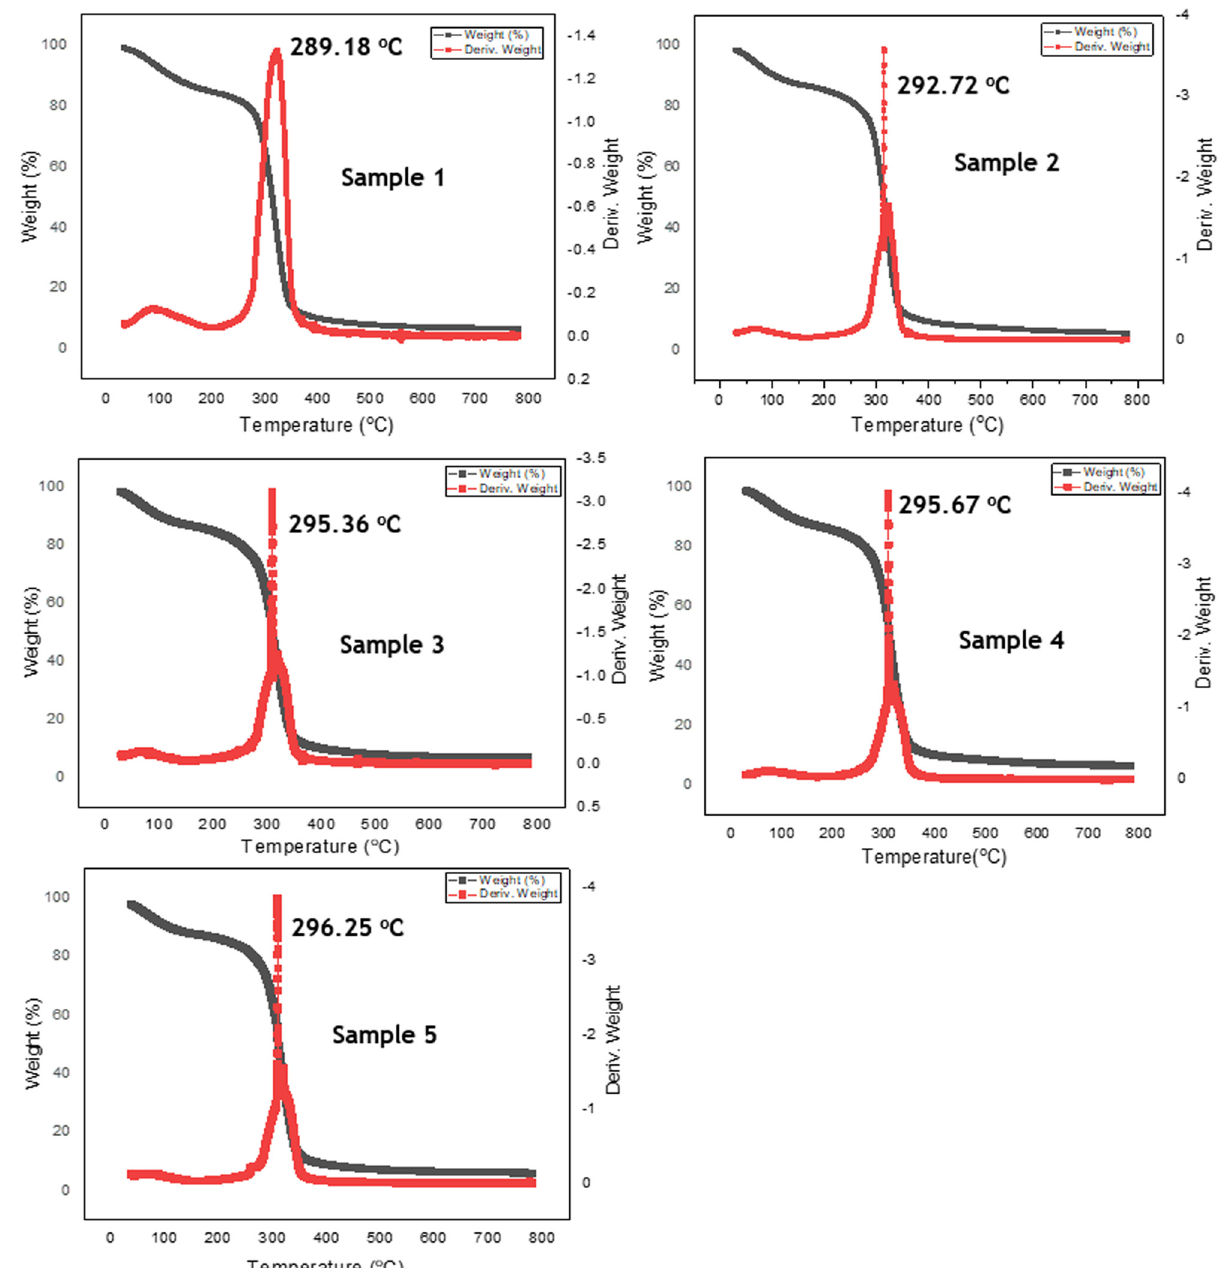
Figure 4: TGA and DTG curves of SPN/SPS and CEO/SPN/SPS biocomposite fi lms in di ff erent